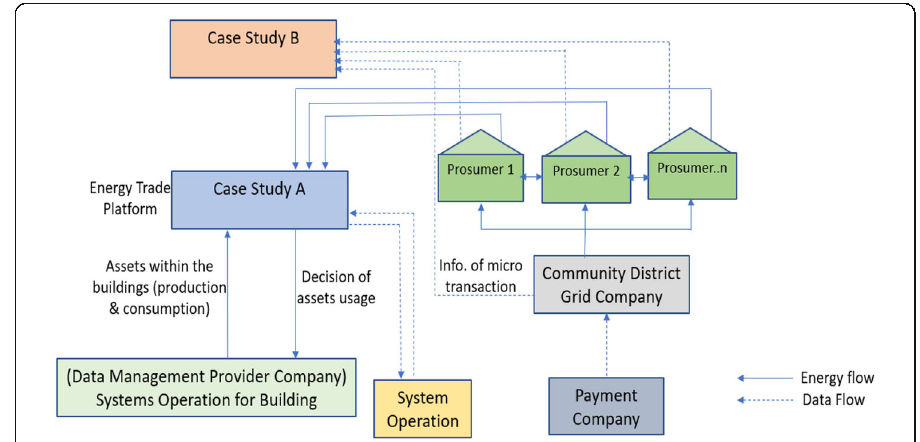
Fig. 5 Energy prosumption operation